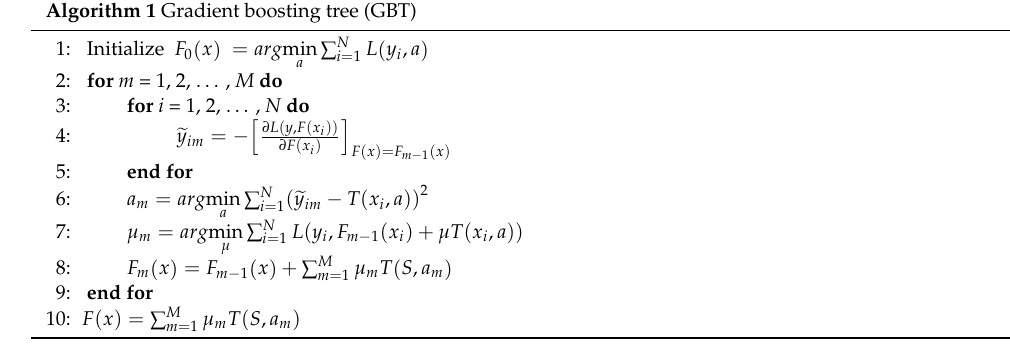
Algorithm 1 Gradient boosting tree